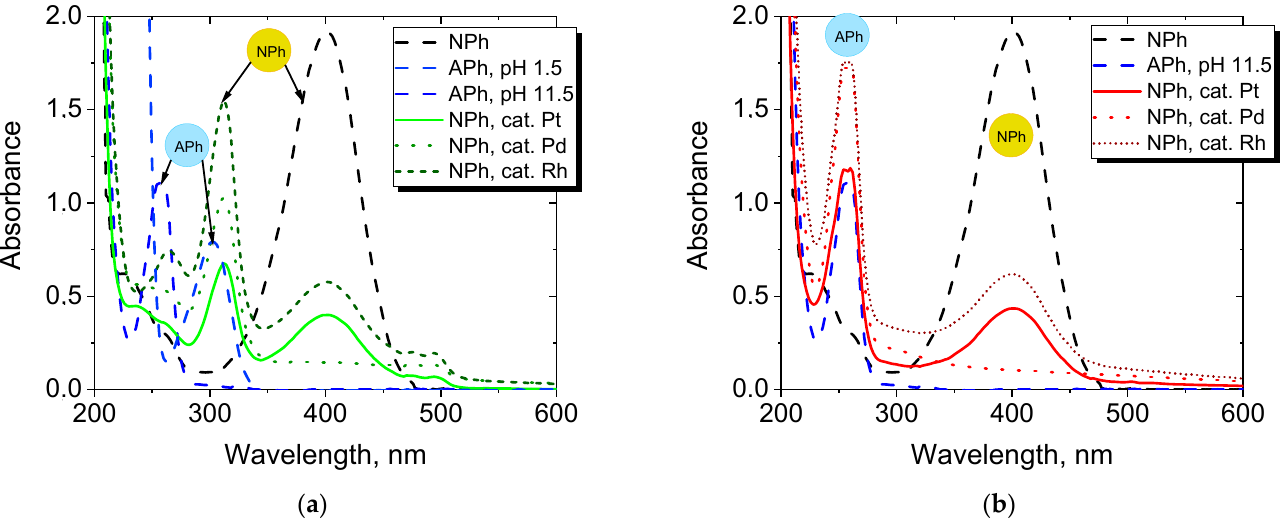
Figure 8. UV-Vis spectra of model solutions of NPh and APh in 11.5 pH and NPh solutions after ( a ) 1 min or ( b ) 30 min of reduction reaction catalyzed by synthesized Pt, Pd or Rh particles.